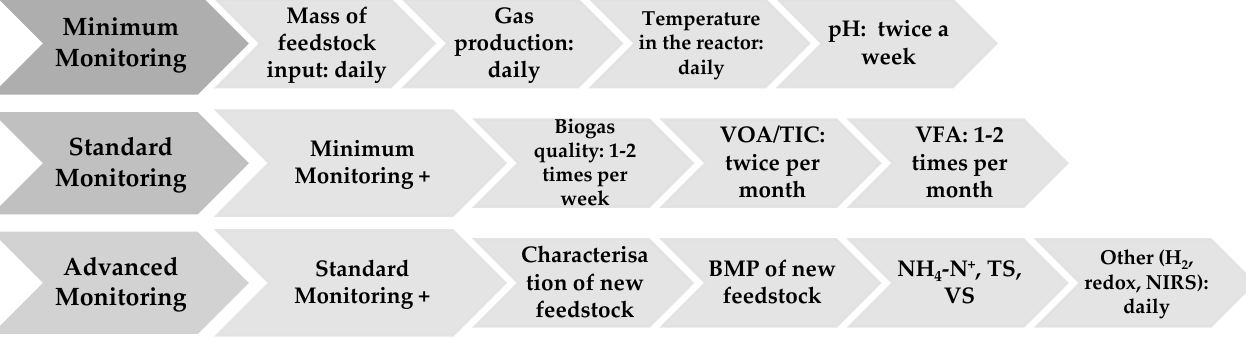
Figure 3. Classification of monitoring strategies [71]. VOA/TIC: Volatile Organic Acids/Total Inorganic Carbon, BMP: Bi – omethane Potential.